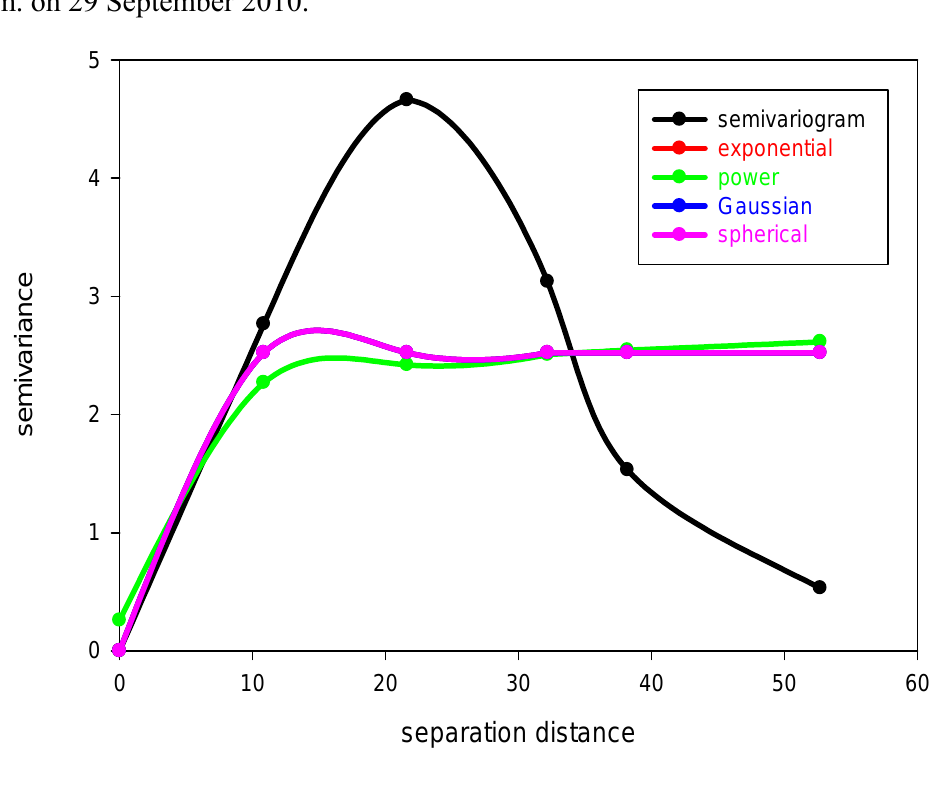
Figure 6. Fitted diagram of experimental and theoretical semivariograms of data obtained at 5 a.m. on 29 September